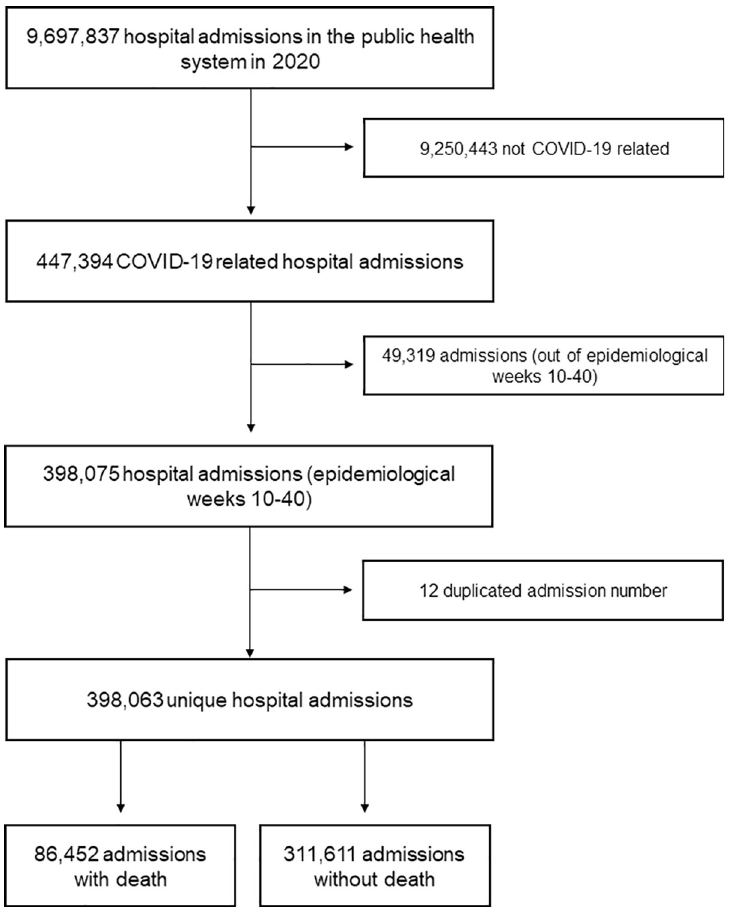
Fig 1. Participant selection flowchart from the hospital admission records, Brazil,